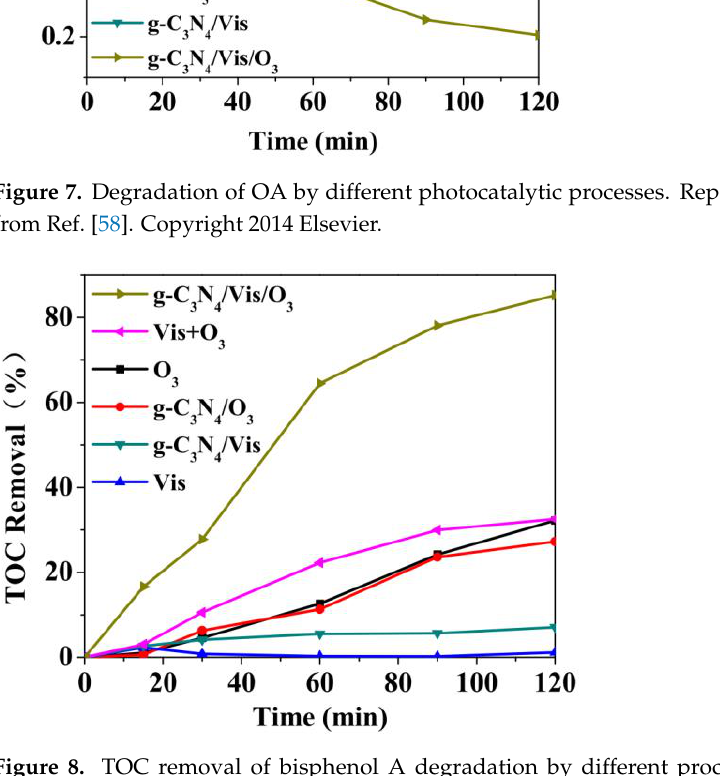
Figure 8. TOC removal of bisphenol A degradation by different processes. Reproduced with permission from Ref. [58]. Copyright 2014 Elsevier.